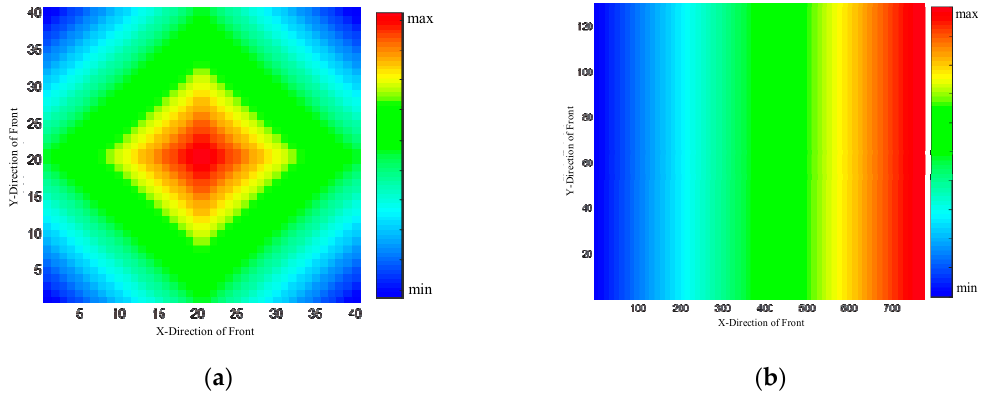
Figure 8. ( a ) Symmetric temperature distribution; ( b ) asymmetric temperature distribution.